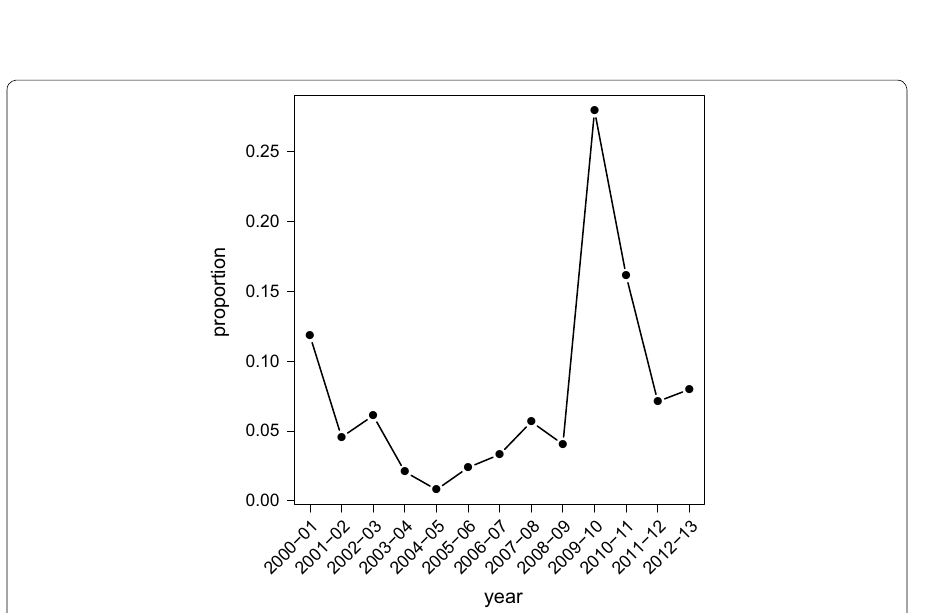
Fig. 4 Proportions of fire ant colonies detected each year from